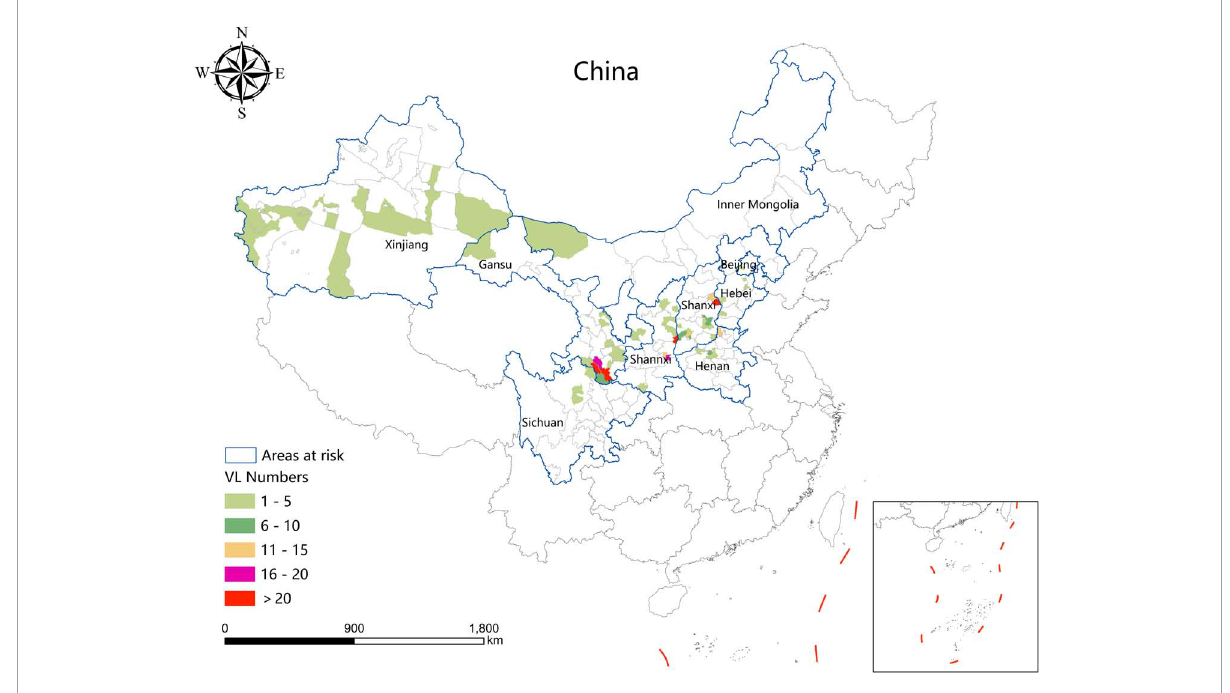
FIGURE3 Cumulative number of visceral leishmaniasis cases between 2019 and 2021.